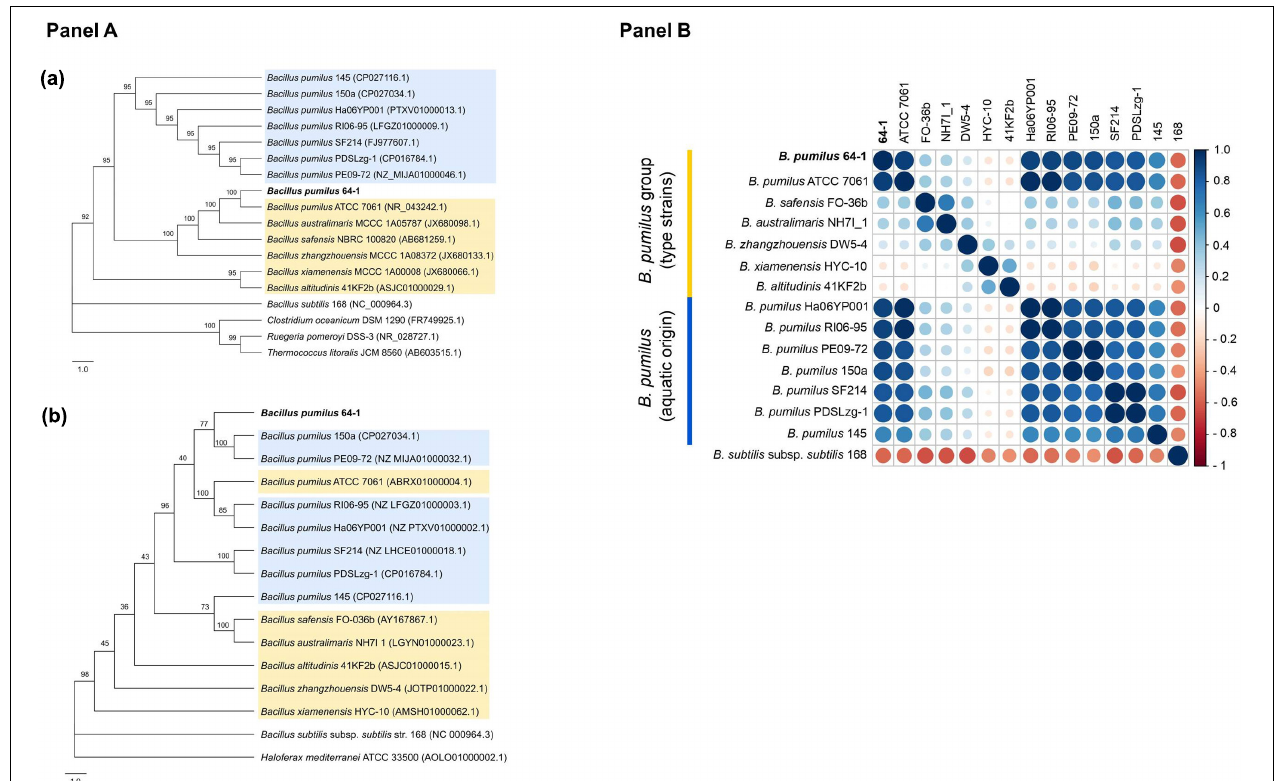
FIGURE 1 | (Panel A) : Phylogenetic trees with the B. pumilus 64-1 with selected representatives ( B. pumilus clade shaded in yellow and aquatic-derived B. pumilus shaded in blue) based on (a) its 16S rRNA and (b) gyrB gene sequences, using the NJ and ML methods, respectively. Bootstrap values are shown at branch nodes. Bar, 1.0 nucleotide substitution (Kunits) rates. For the 16S rRNA NJ tree, B. subtilis subsp. subtilis 168 (NC 000964.3), C. oceanicum DSM 1290T (FR749925.1), R. pomeroyi DSS-3 (NR 028727.1) and T. litoralis JCM 8560 (AB603515.1) were chosen as outgroups. For the gyrB ML tree, B. subtilis subsp. subtilis 168 (NC 000964.3) and H. mediterranei ATCC 33500 (AOLO01000002.1) were set as outgroups. Trees were generated by MEGAX software and depicted with FigTree. (Panel B) : Correlation plot based on ANIm values (%) obtained by the JSpeciesWS. The R program was used to the construction of a Pearson correlation